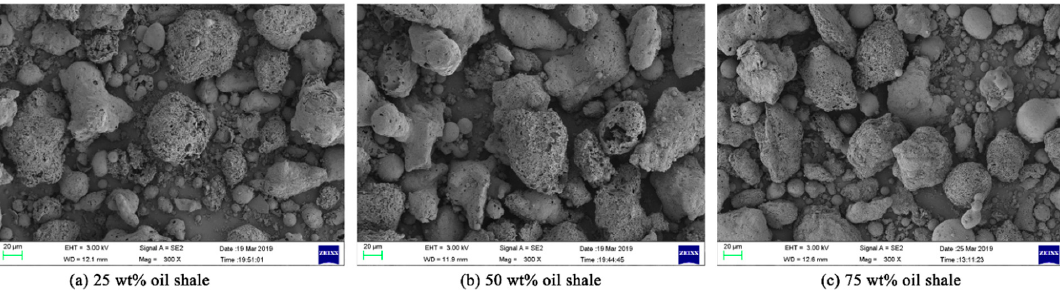
Figure 11. SEM images of the oil shale-coal dust mixture after explosion under the